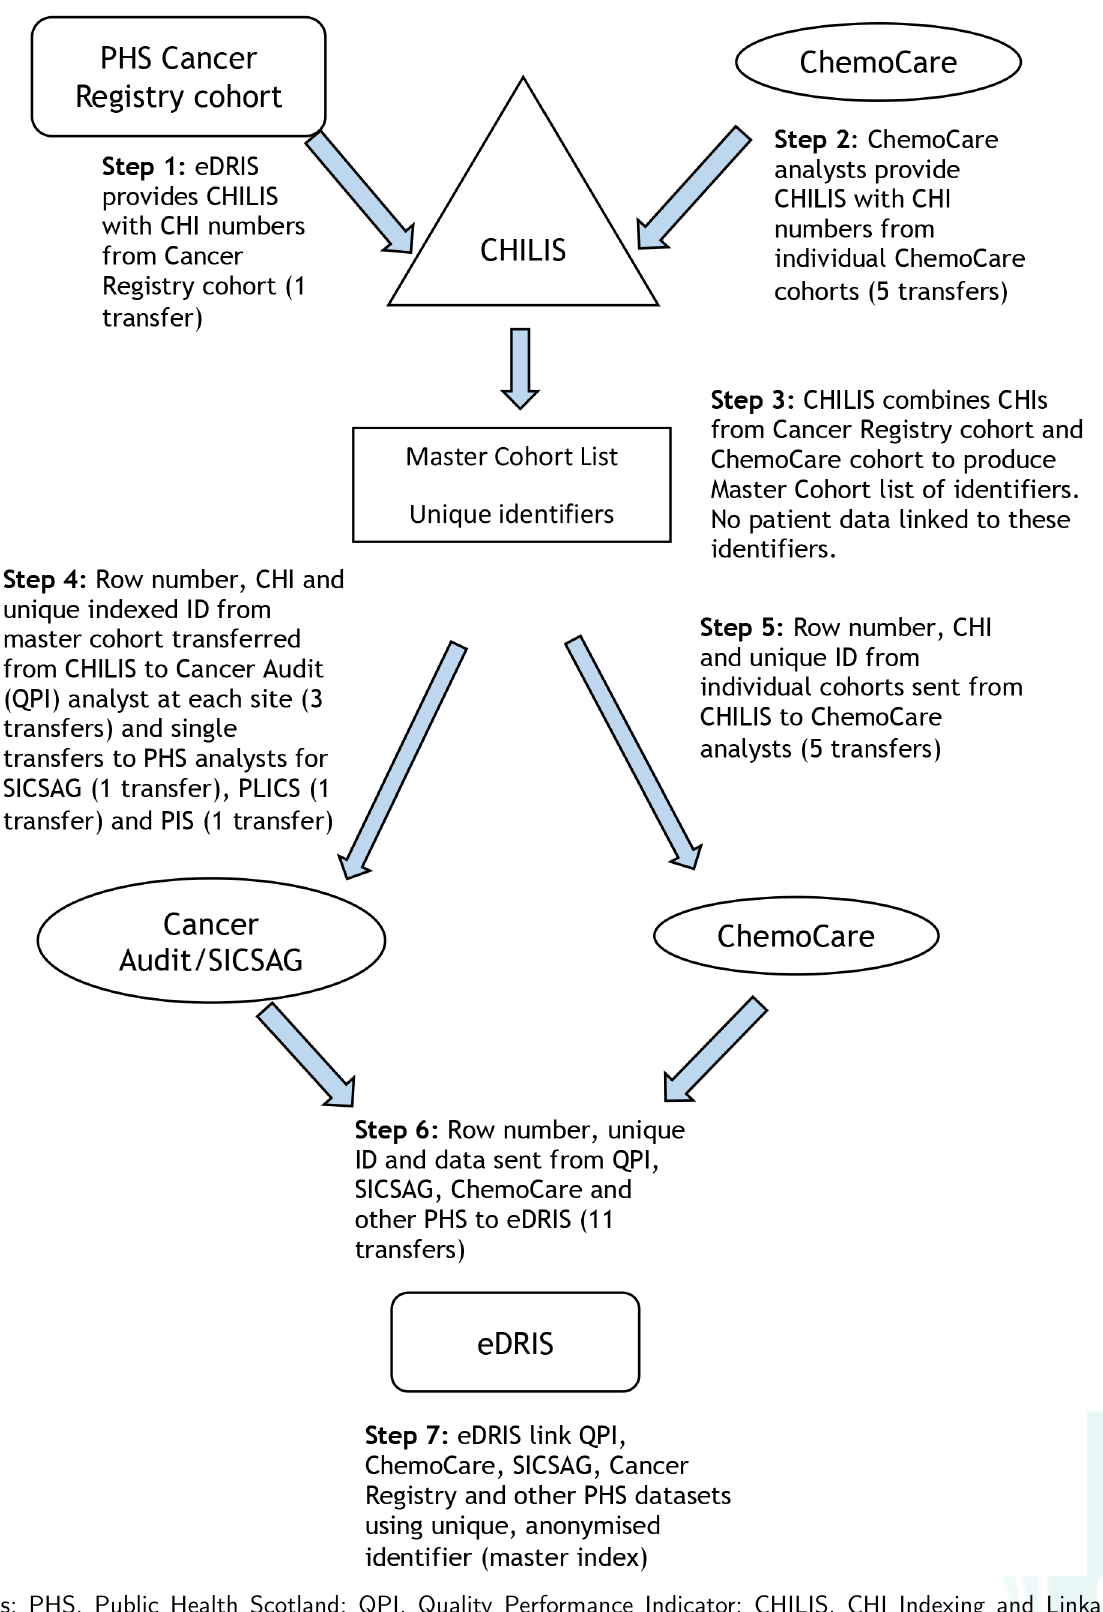
Figure 2: Cohort definition and transfer of datasets to Public Health